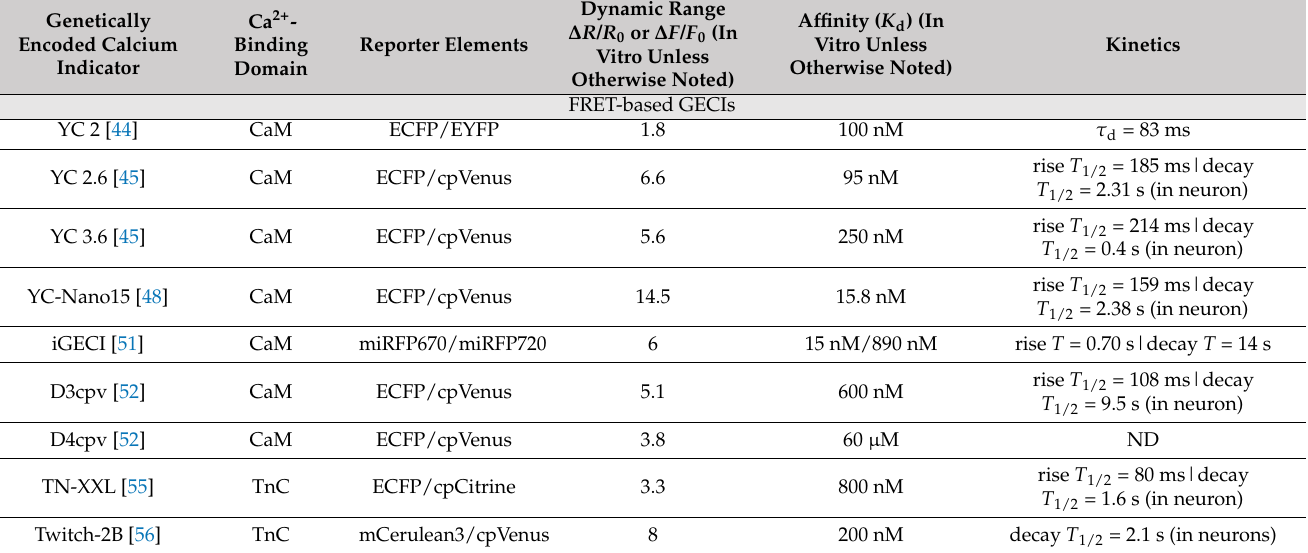
Table 2. Key metrics of selected genetically encoded calcium